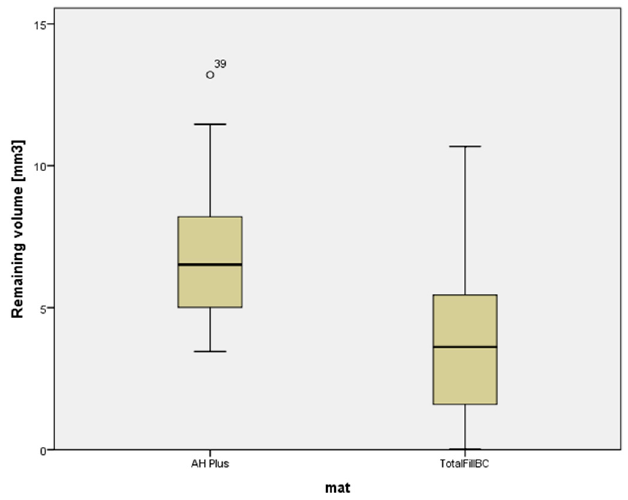
Figure 3. Plots of the scores dedicated to remaining filling material in two groups after retreatment.